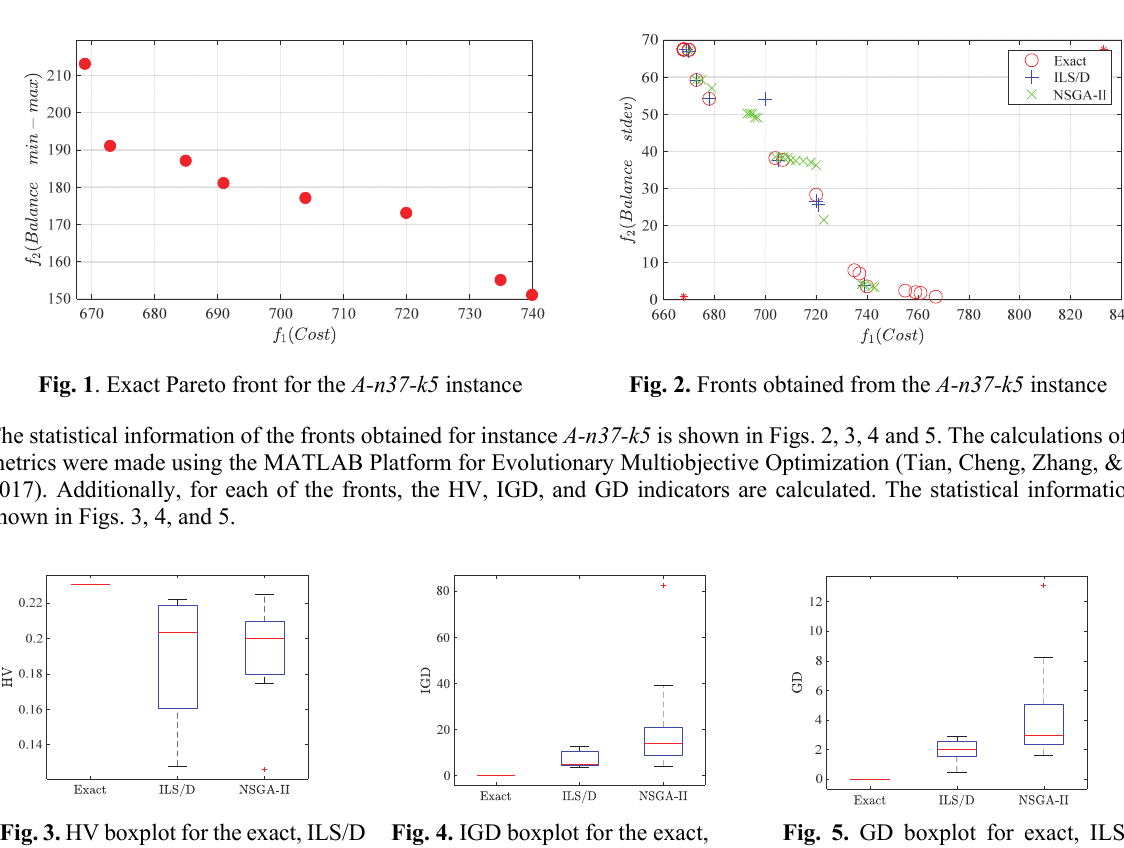
Fig. 4. IGD boxplot for the exact, ILS/D and NSGA-II algorithms for the A-n37-k5 instance